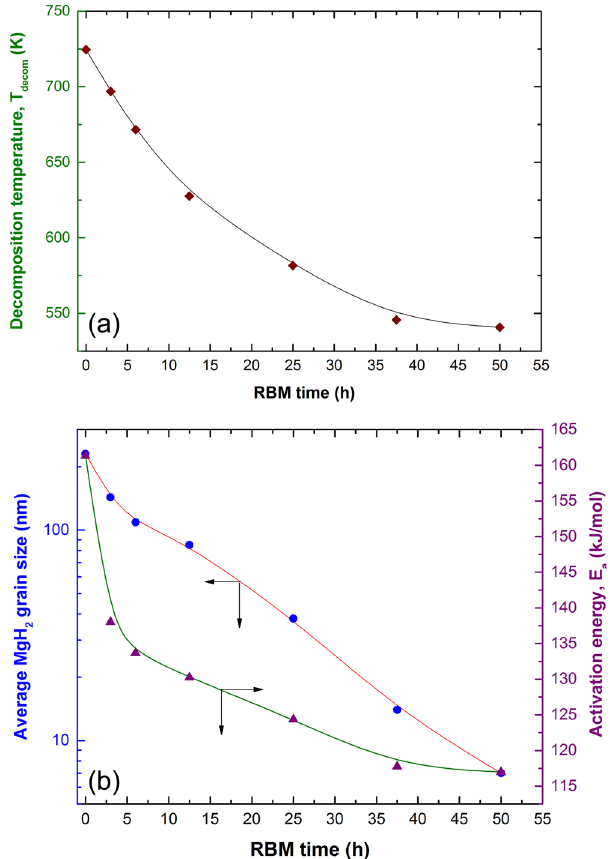
Figure 5. Correlation between RBM time, decomposition temperature, MgH 2 grain size and activation energy of nanocomposite MgH 2 /5 wt.% TiMn 2 powders. ( a ) Influence of RBM time on the decomposition temperature, T decom for nanocomposite MgH 2 /5 wt.% TiMn 2 powders. The effect of RBM time on MgH2 grain size and activation energy, E a of nanocomposite MgH 2 /5 wt.% TiMn 2 powders are elucidated in ( b